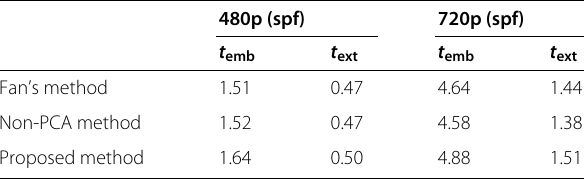
Table 7 The computational time in the process of message embedding or extraction 480p